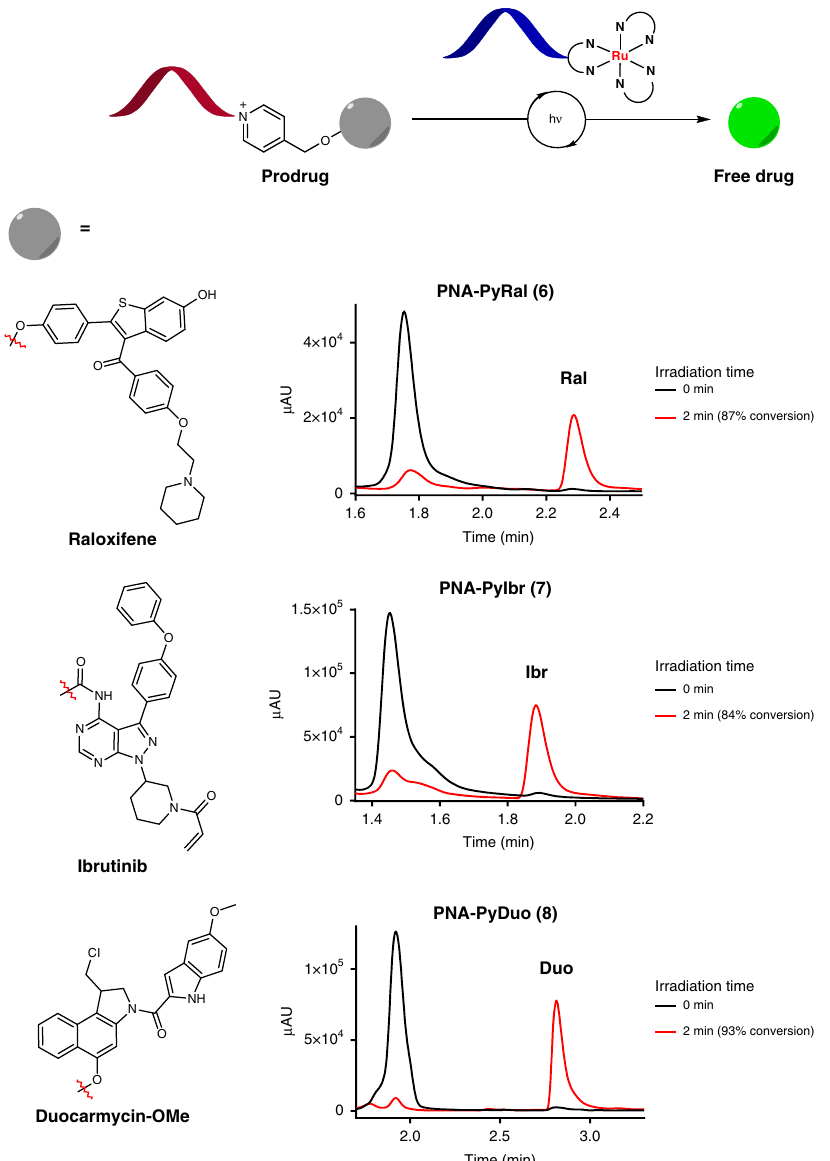
Fig. 3 PNA-templated photoreductive release of effector molecules by ruthenium photocatalysis. Ru-PNA-5mer ( 5 ) (10 µ M), PNA-Py-Drug ( 6 – 8 ) (100 µ M), sodium ascorbate (10 mM) in PBS 1X(pH 7.4). Irradiation with 455 nm light before and after 2 min was followed by LC-MS quanti fi